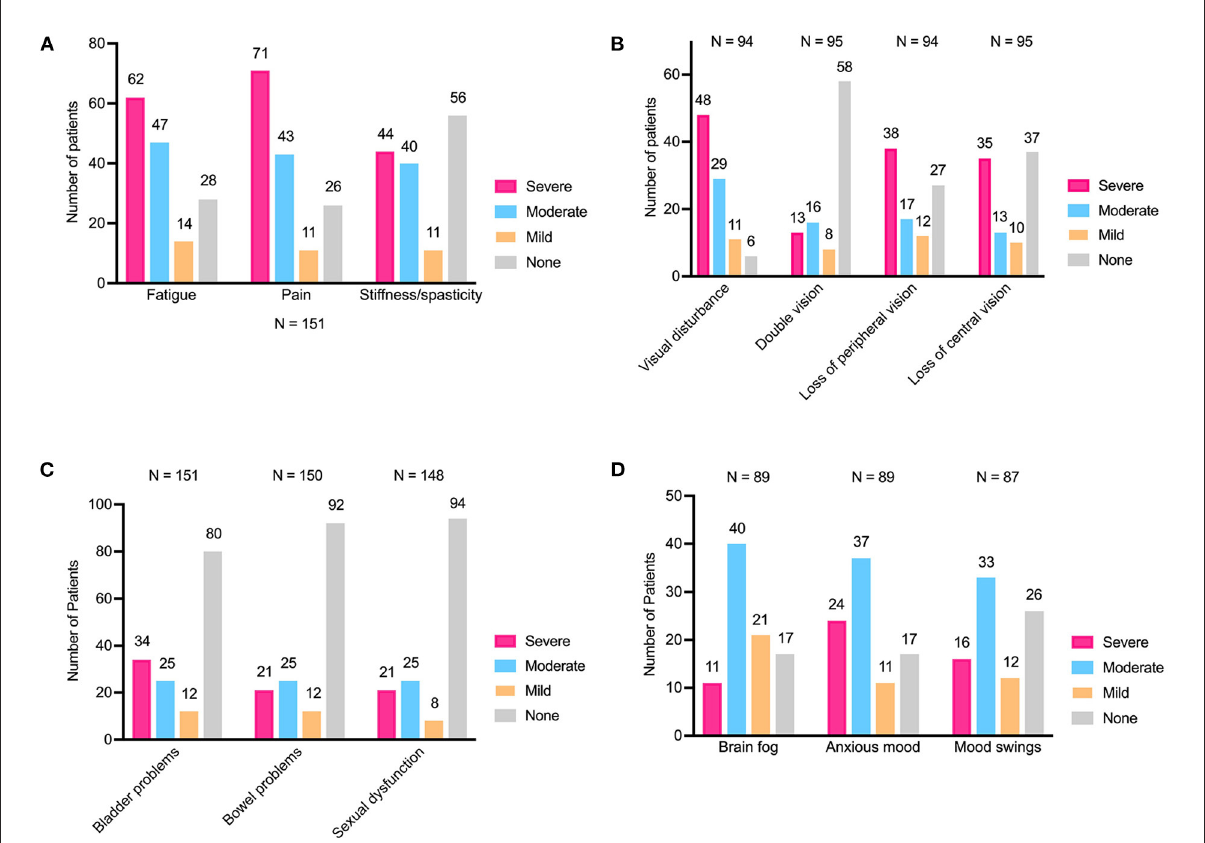
FIGURE3 Signs and symptoms encountered during an initial attack of NMOSD. (A) Fatigue, pain, and stiffness/spasticity. (B) Visual disturbances, double vision, loss of peripheral vision, and loss of central vision. (C) Bladder and bowel problems, sexual dysfunction. (D) Brain fog, anxious mood, and mood swings. NMOSD indicates neuromyelitis optica spectrum